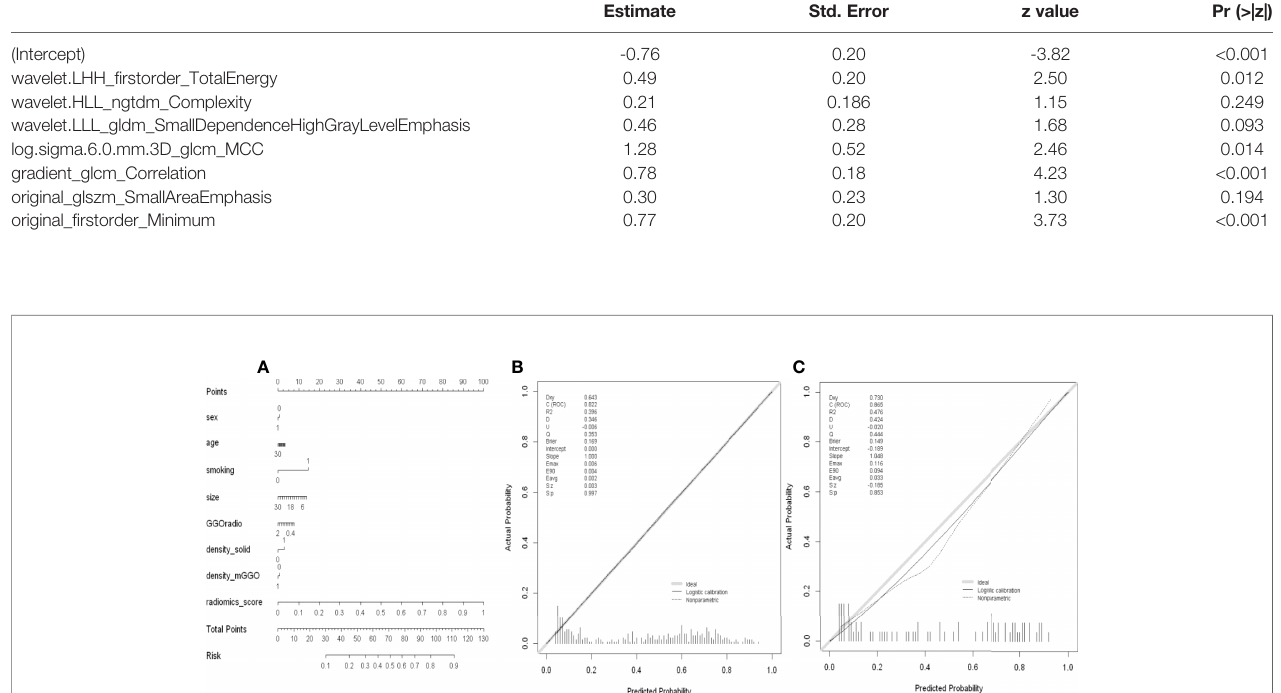
TABLE 4 | Features included in the radiomics model and their coef fi cients.